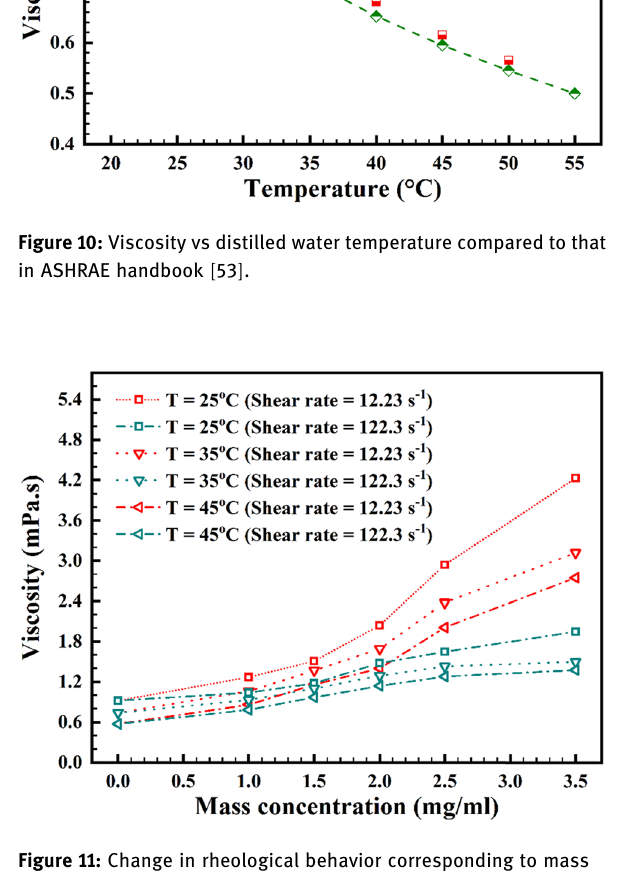
Figure 11: Change in rheological behavior corresponding to mass concentration at varied